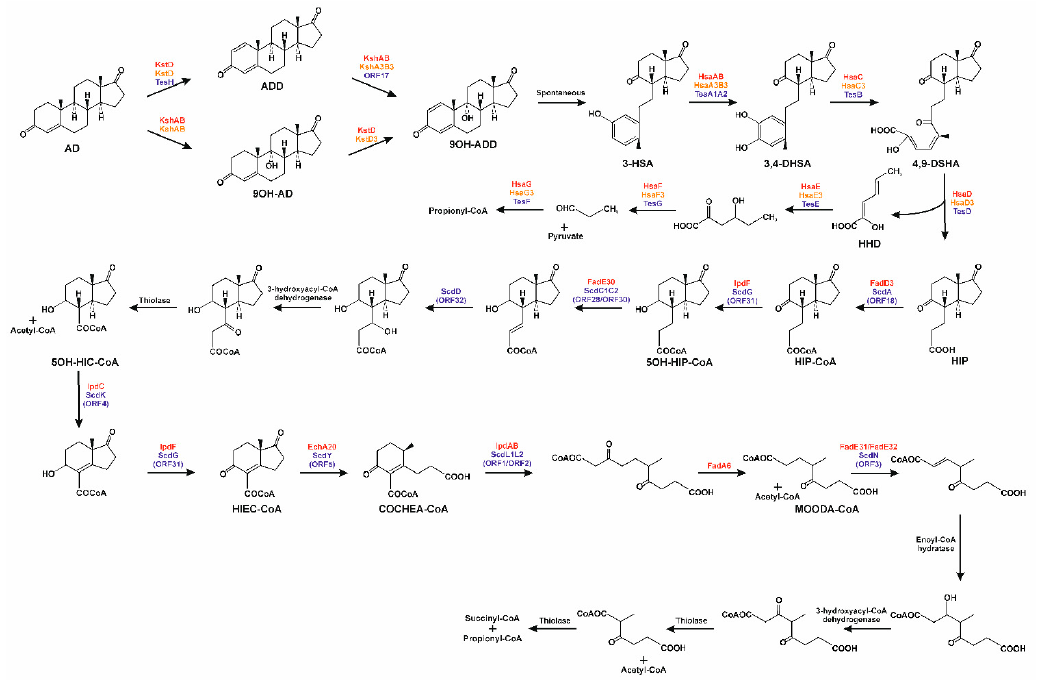
Figure 7. Proposed 9,10- seco pathway from androst-4-en-3,17-dione to central metabolites, pyruvate, acetyl-CoA, propionyl-CoA, and succinyl-CoA. AD, androst-4-en-3,17-dione; ADD, androst-1,4-dien-3,17-dione; 9OH-AD, 9-hydroxy-androst-4-en-3,17-dione; 9OH-ADD, 9-hydroxy-androst-1,4-dien-3,17-dione; 3-HAS, 3-hydroxy-9,10-secoandrosta-1,3,5(10)-triene-9,17-dione; 3,4-DHSA, 3,4-dihydroxy-9,10-secoandrosta-1,3,5(10)-triene-9,17-dione; 4,9-DSHA, 4,5,9,10-diseco-3-hydroxy-5-9-17- trioxoandrosta-1(10),2-diene-4-oic acid; HHD, 2-hydroxy-2,4-hexadienoic acid; HIP, 3a α -H-4 α (3’-propanoate)7a- β -methylhexahydro-1,5-indanedione; 5OH-HIP-CoA, 3a α -H-4 α (3’-propanoyl-CoA)-5-hydroxy-7a- β -methylhexahydro-1-indanone; 5OH-HIC-CoA, 3a α -H-4 α (3’-carboxyl-CoA)-5-hydroxy-7a- β -methylhexahydro-1-indanone; HIEC-CoA, (7a S )-7a-methyl-1,5-dioxo-2,3,5,6,7,7a-hexahydro-1 H -indene-4-carboxyl-CoA; COCHEA-CoA, 2-(2-carboxyethyl)-3-methyl-6-oxocyclohex-1-ene-1-carboxyl-CoA; MOODA-CoA, 4-methyl-5-oxo-octanedioyl-CoA. Actinobacterial enzymes from cholesterol metabolism are indicated in red, actinobacterial enzymes involved in cholic acid catabolism are indicated in orange, and those from catabolism of testosterone and cholic acid from Comamonas spp. are written in blue.